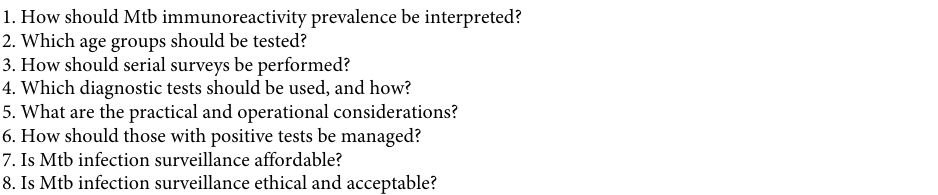
Table 2. Core considerations for surveillance based on Mtb